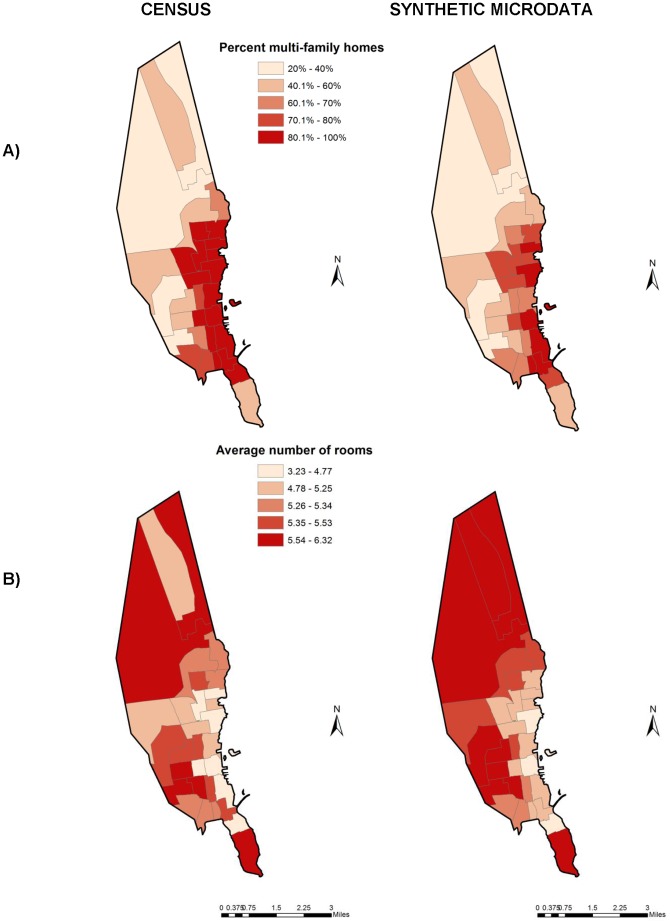
A) Percentage of multi-family homes and B) average number of rooms per household by census tract in New Bedford, as reported by the American Community Survey and estimated by synthetic microdata.